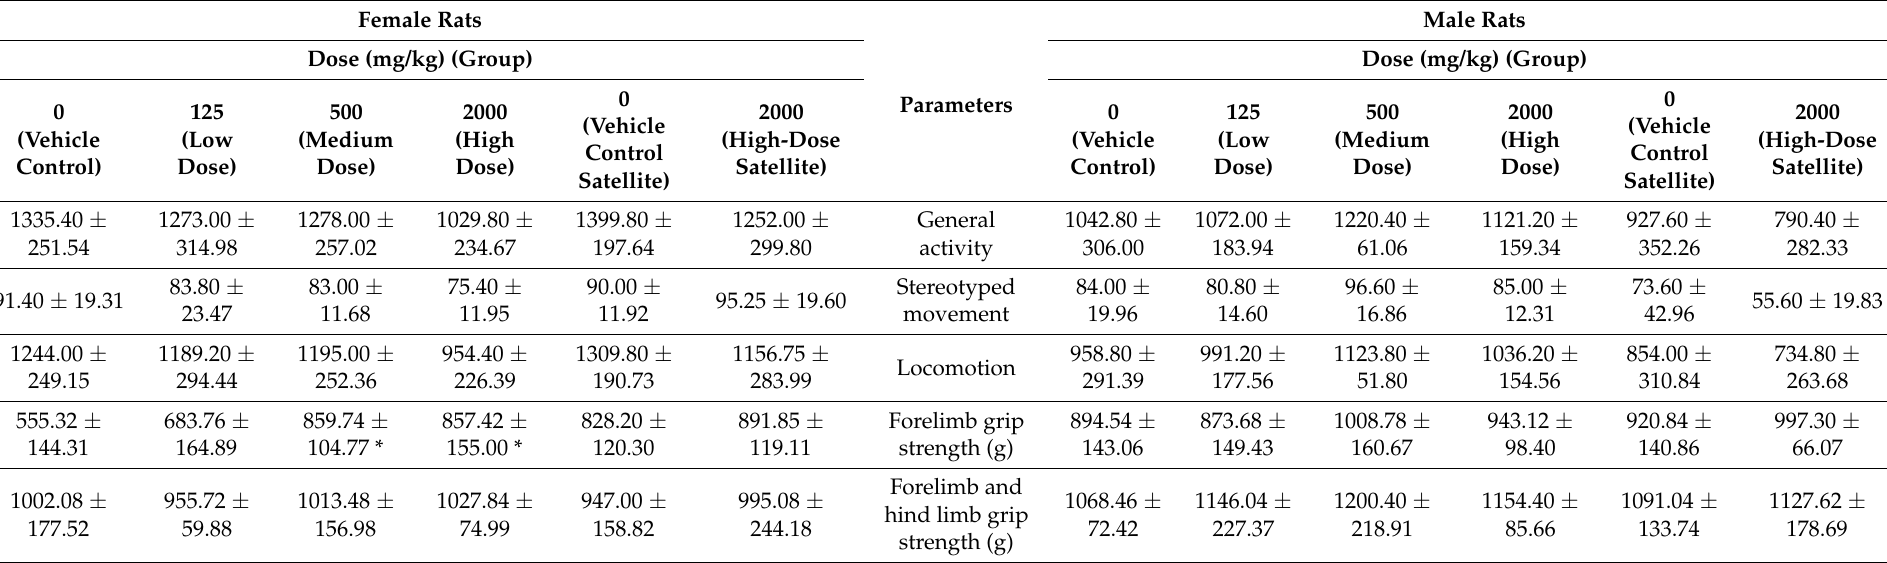
Table 2. Summary of functional observations on motor activity and grip strength in female and male